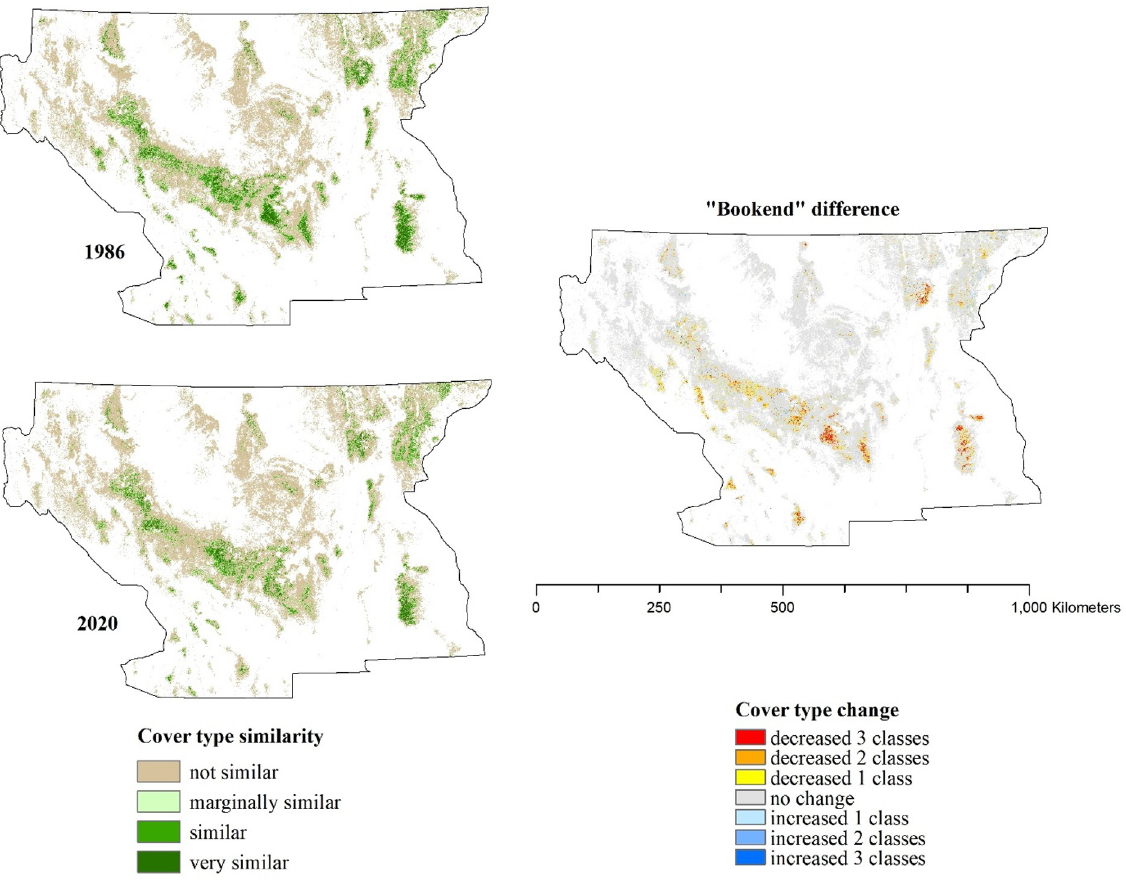
Fig 7. “Bookend” changes in Mexican spotted owl cover type over a 35-year period. The distribution of cover type classes for 1986 and 2020 are shown on the left, and the differenced map showing spatial changes in cover type classes over the study period is shown on the right. Cover type mapping is masked to limits of potential forested land according to the National Land Cover